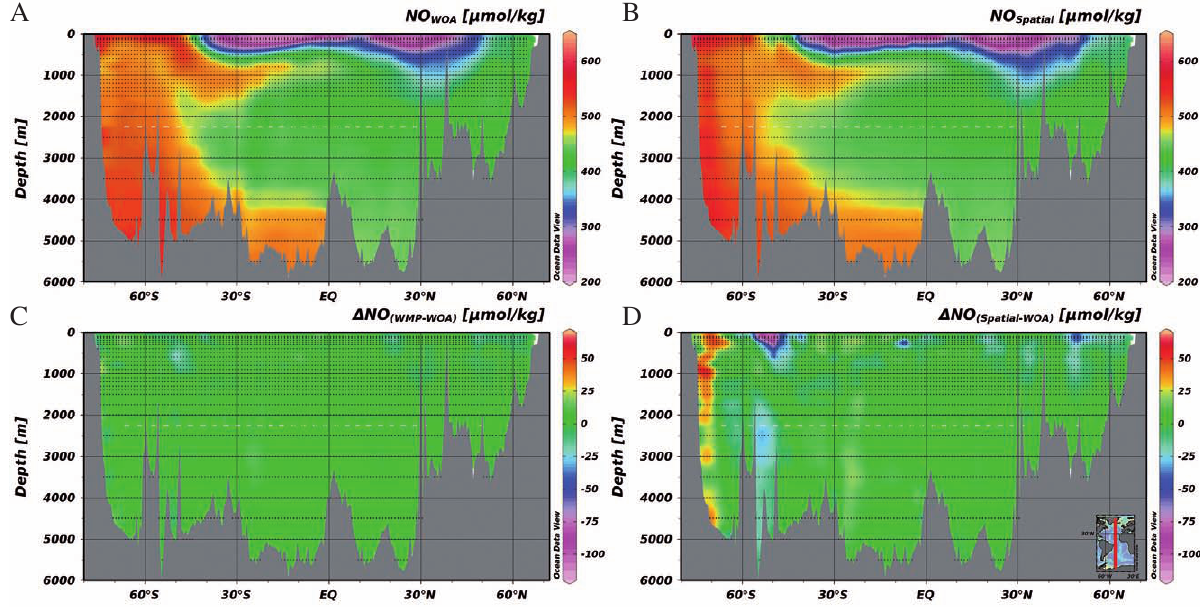
Fig . 4. – NO (µmol kg -1 ) variability along 28ºW from the WOA05 dataset (A), spatially interpolated from CARINA data (B). Residuals of WMP interpolated (C) and spatially interpolated (D) NO, both as interpolated minus WOA05.